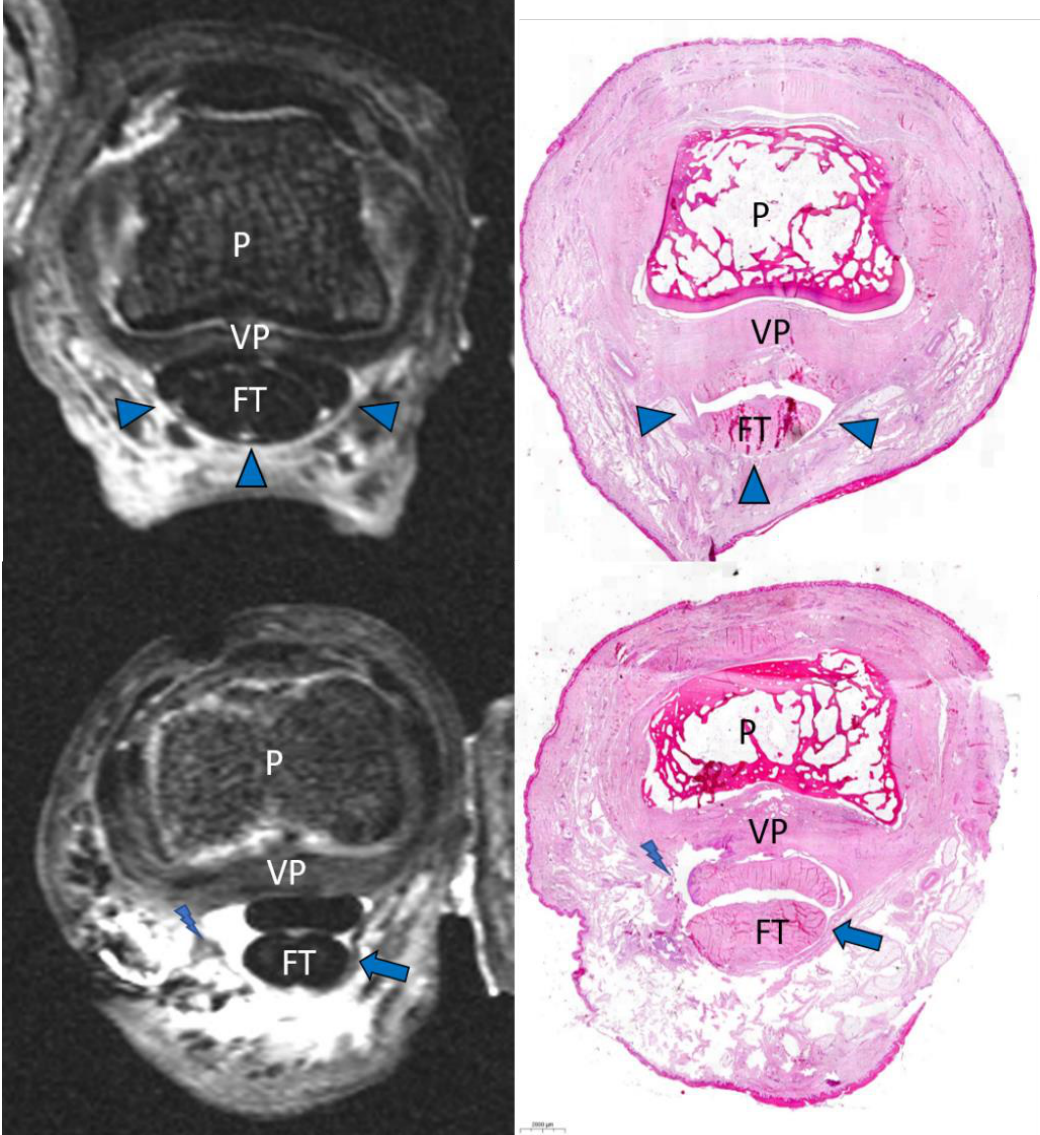
Figure 3. Comparison of an A3 pulley before and after rupture. Axial PD fs and histologic correlation before rupture creation ( above ) and after rupture creation ( below ). P = phalanx. This A3 rupture was characterized and confirmed as grade 1 (SMOOTH.RUPT). FT = flexor tendon. Arrowhead = intact A3 pulley. Arrow = disrupted pulley stump. Lightning bolt = exact spot of rupture. VP = volar plate.